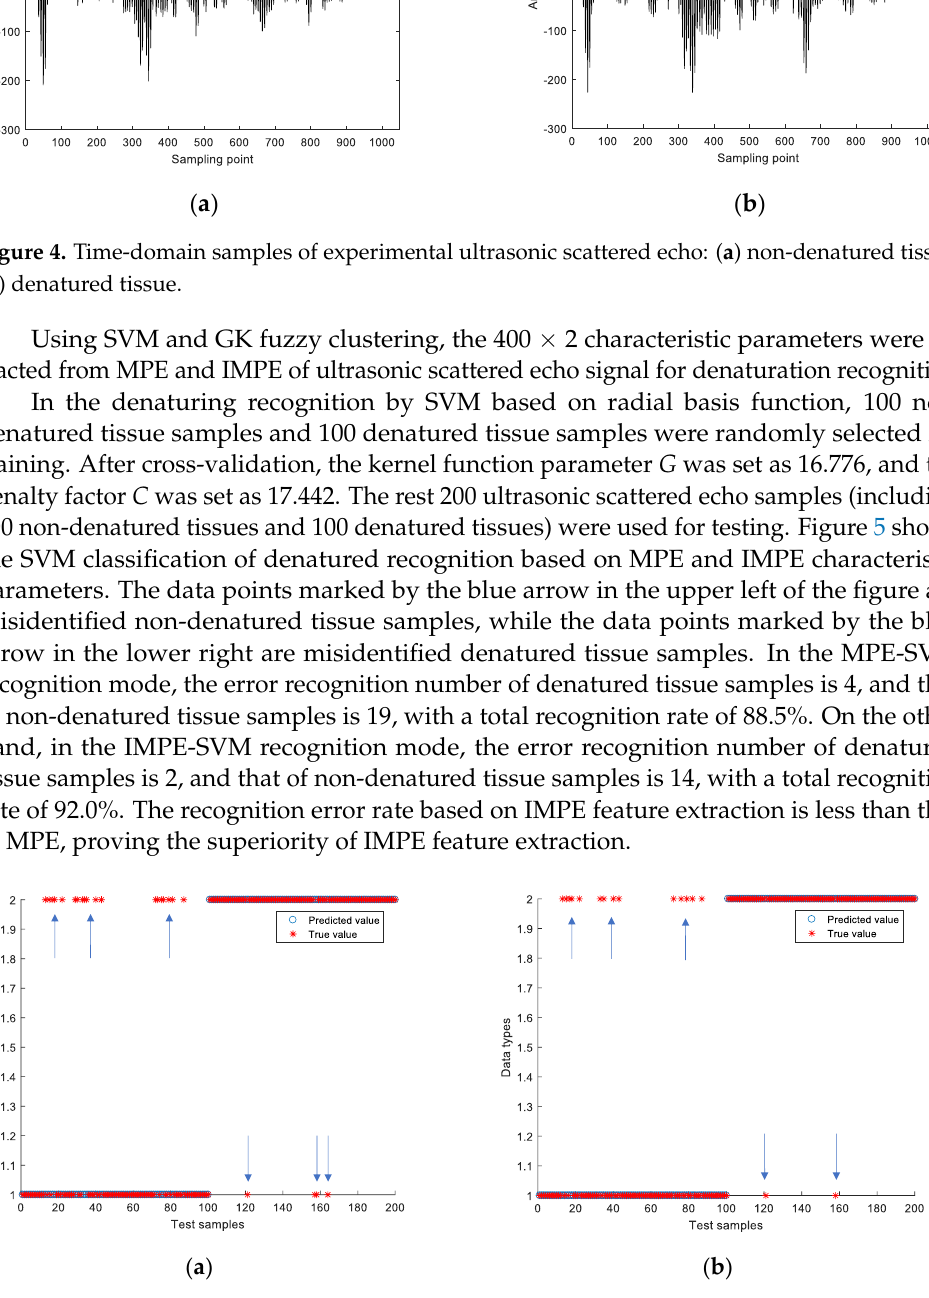
Figure 5. Recognition of denatured and non-denatured tissue based on support vector machine (SVM): ( a ) MPE-SVM; ( b )